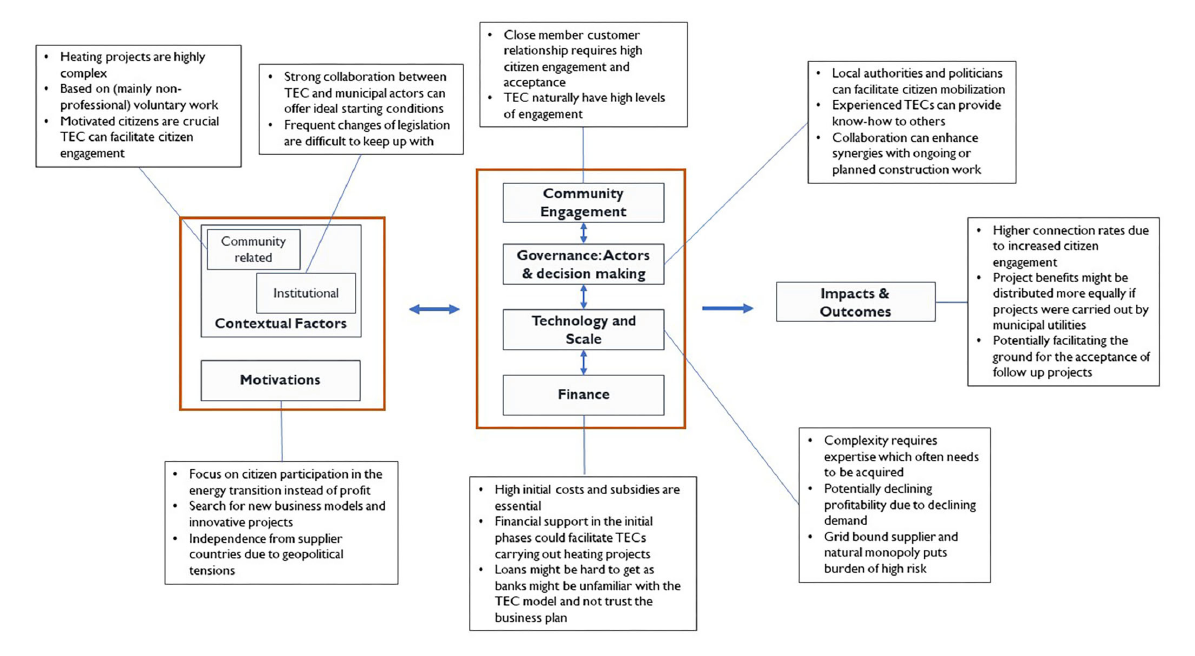
FIGURE2 Key take-aways from the